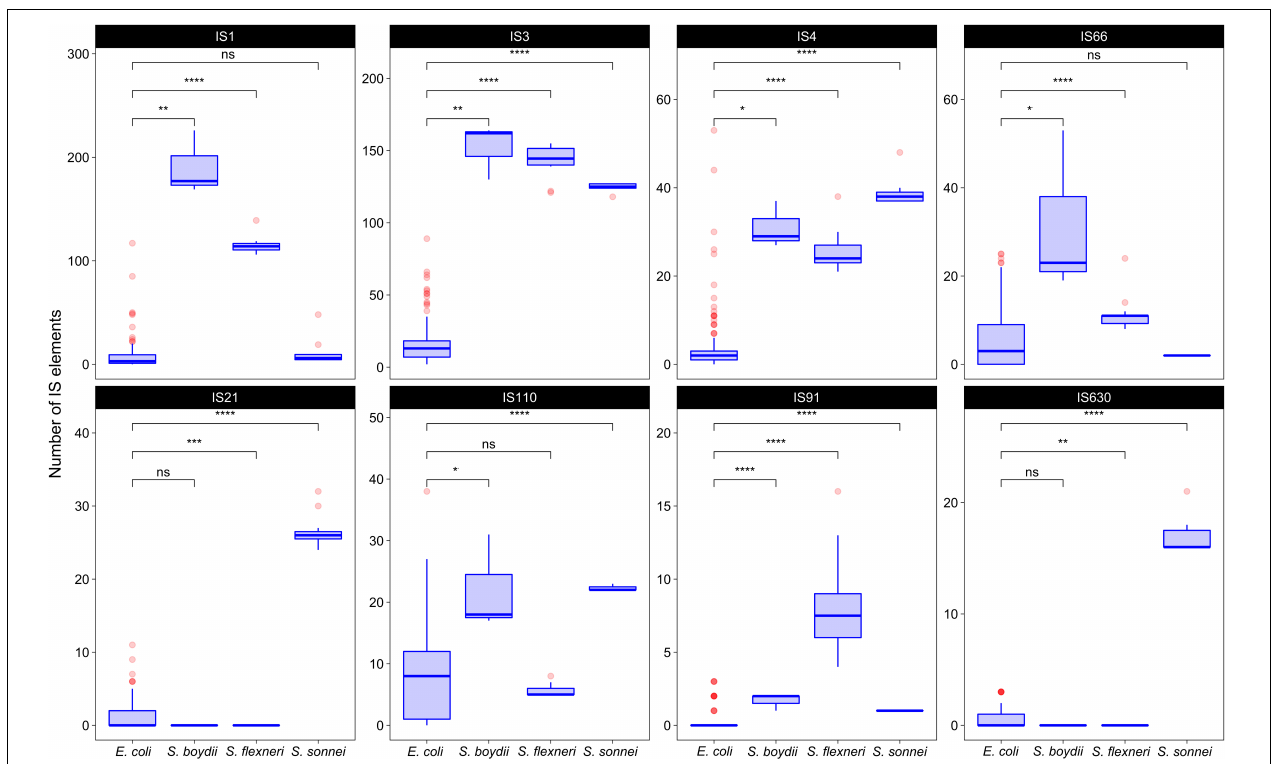
FIGURE 4 | The comparison of selected IS families in Shigella and E. coli strains from phylogroup B1. The Wilcoxon–Mann–Whitney test with the Bonferroni correction: ∗ p ≤ 0.05; ∗∗ p ≤ 0.01; ∗∗∗ p ≤ 0.001; ∗∗∗∗ p ≤ 0.0001, ns,